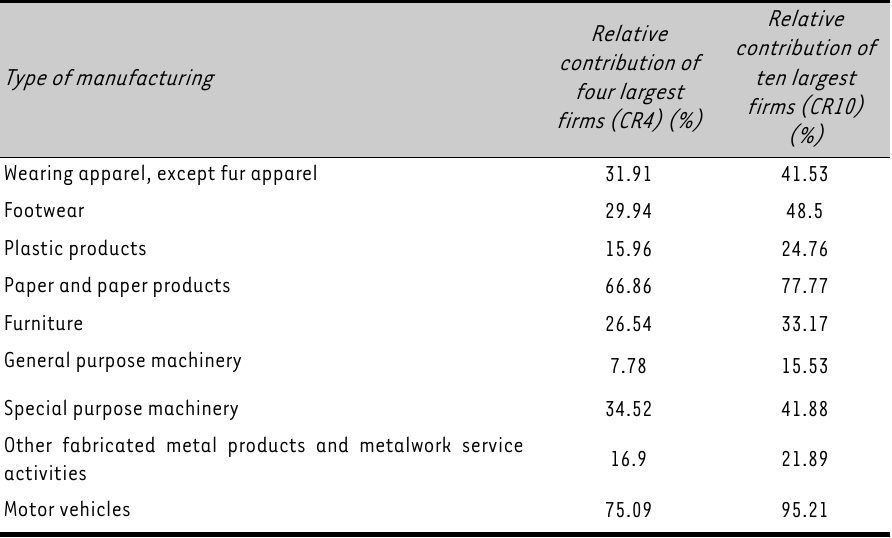
TABLE 2: Some downstream concentration ratios in the manufacturing industry according to output: 2005